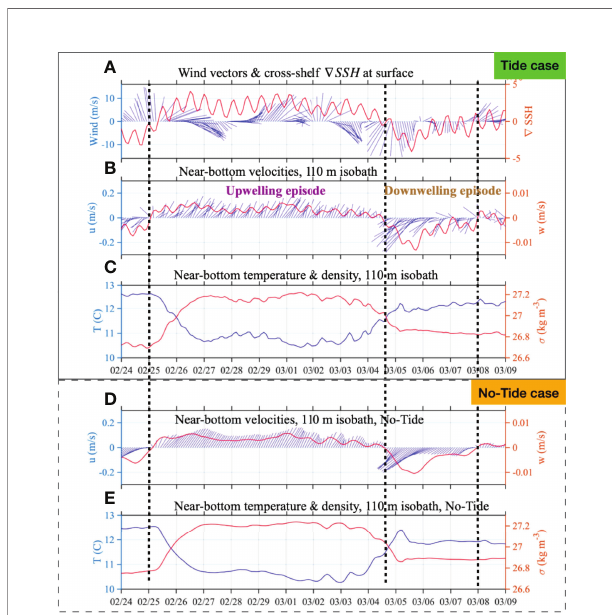
FIGURE 7 | Time series of forcing conditions and fl ow responses at the canyon head. The point from where the model outputs are extracted is located at about 10 m above bottom at 110 m isobath near the canyon head: (A) wind vectors and cross-shelf SSH gradient (positive is seaward), (B) near bottom velocities (full forcing with tides), (C) near bottom temperature and density, (D) near bottom velocities (no tides), and (E) near bottom temperature and density (no tides). The canyon upwelling event lasted for 8.5 days from February 25 to March 4, 2016, persisted through multiple tidal cycles, and consisted of a 2-day ramp-up phase, a 5-day quasi steady phase, and a 1.5-day relaxation phase. The ensuing downwelling event lasted for 3.5 days from March 4-7, and consisted of 1.5 days of ramp-up, and 2 days of